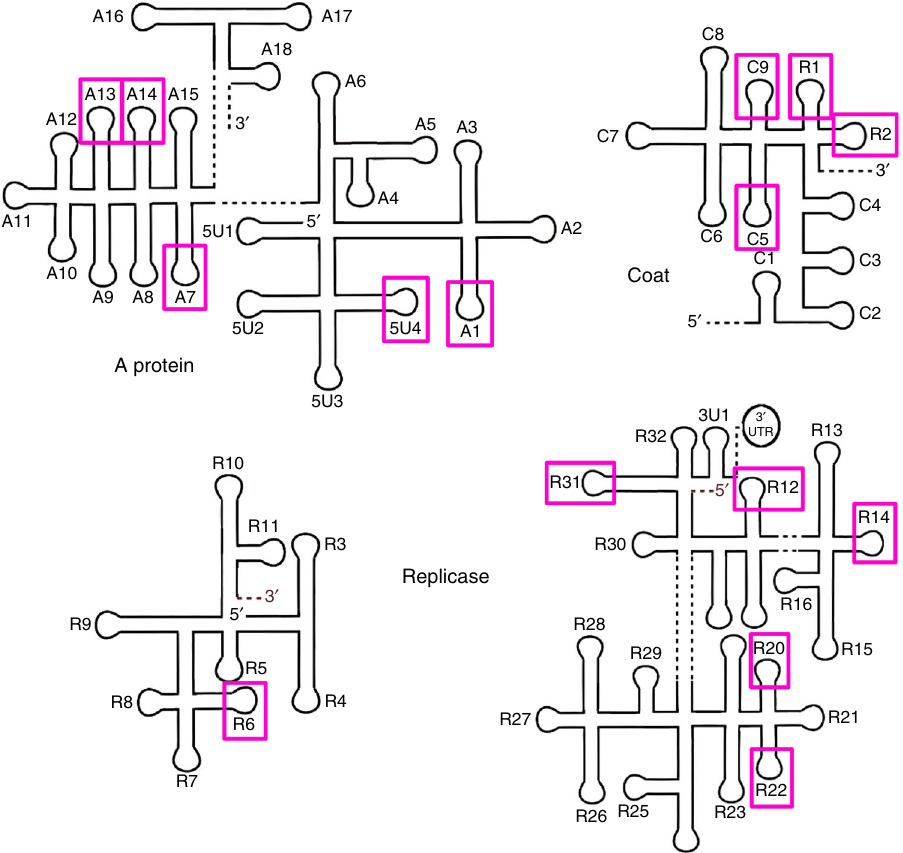
Fig. 2 PSs in the MS2 genome predicted by HPA analysis and con fi rmed by cryo-EM. The secondary structure of the MS2 genome is shown as a series of stem-loops (SLs), with the 15 SLs seen in the TR binding sites of the phage coat protein dimers in the asymmetric cryo-EM reconstruction 2 , and predicted to be PSs via HPA (Dykeman et al 7 ), indicated by magenta boxes. Other SLs in the genome share characteristic MS2 coat protein recognition motifs with these 15 PSs, and were also proposed to be PSs. It is possible that at least some of these also contact coat protein dimers during PS-mediated assembly, but disengage thereafter and thus are not visible in the virion. Genomic SLs are numbered increasing in the 5 ′ -to-3 ′ direction, preceded by their genetic